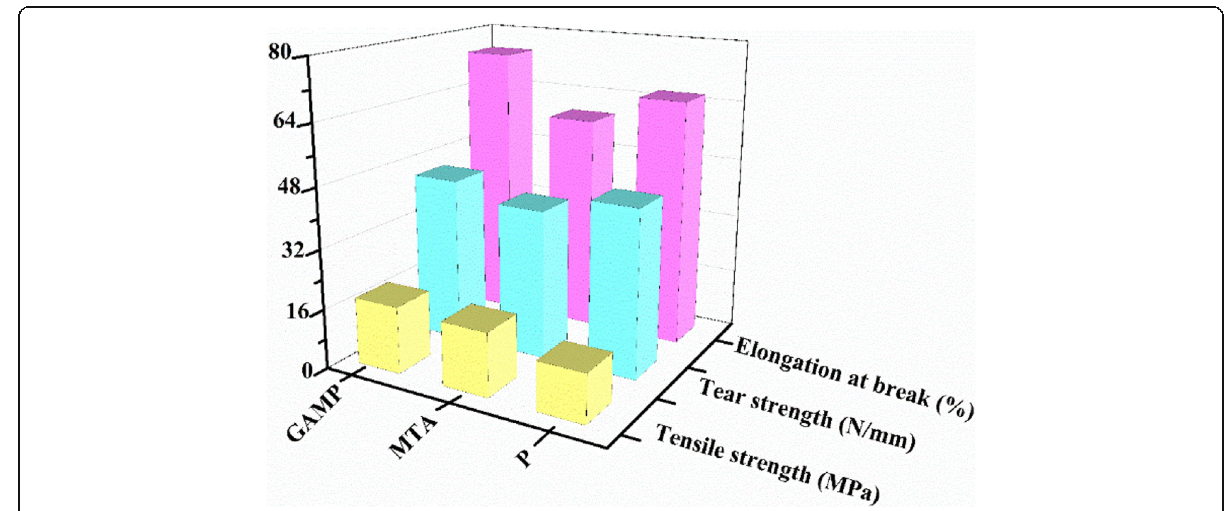
Fig. 8 Physical and mechanical properties of leather samples retanned with the different retanning agents